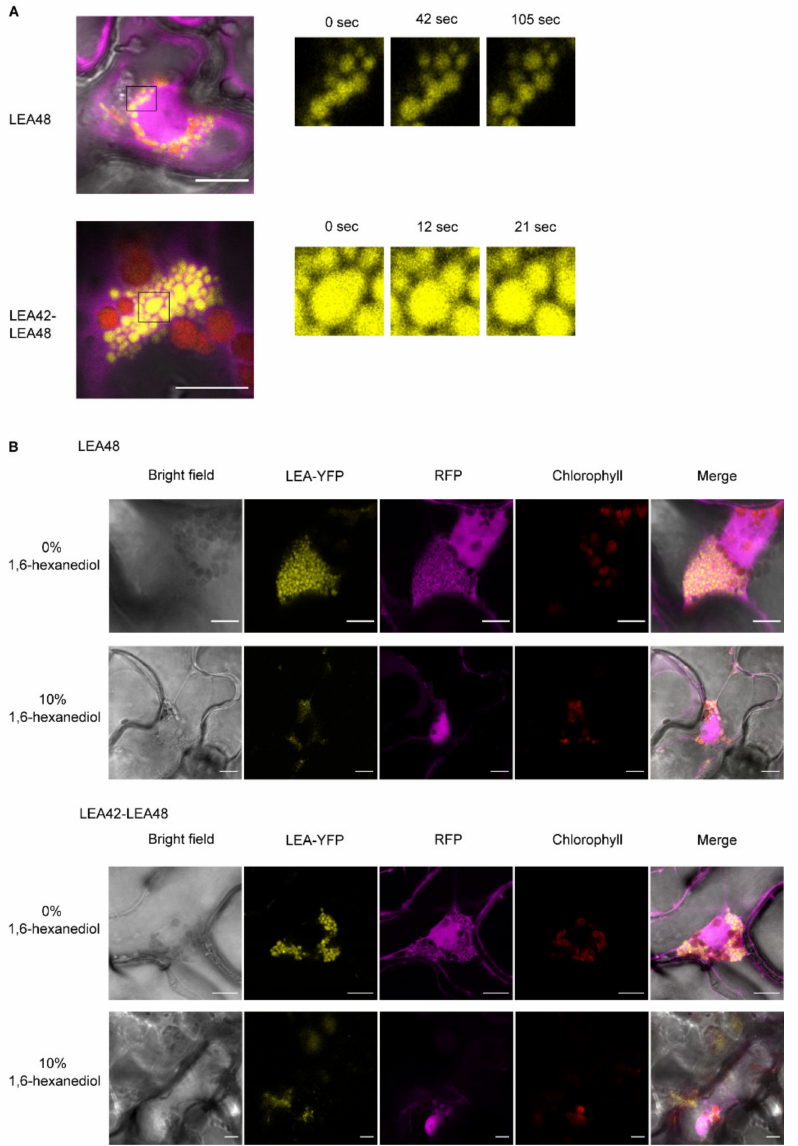
Figure 5. Liquid-liquid phase separation investigation of LEA48 homodimeric and LEA42-LEA48 heterodimeric complexes. ( A ) Separations of droplets. ( B ) Complexes after 0% or 10% 1,6-hexanediol treatment of N. benthamiana leaves 4 d after infiltration. Bars indicate 10 µ